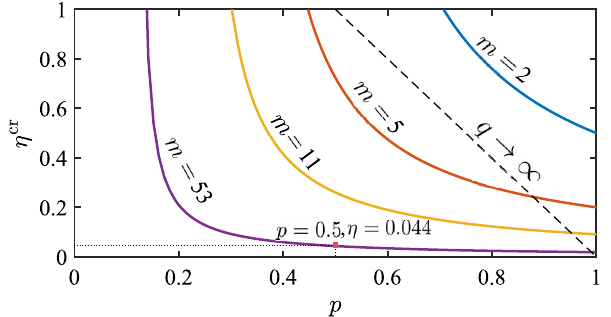
FIG. 2. Noise robustness and loss tolerance. Dependence of the critical heralding efficiency η cr for Alice with respect to the noise parameter p in the bipartite shared state ρ AB ð p Þ when using m ¼ d MUB measurement settings to demonstrate EPR steering in dimension d . By increasing the number of measurement settings m (or increasing the dimensions d ), the critical efficiency η cr decreases substantially, even at significant noise levels ( p < 1 ). For example, with m ¼ 53 MUB settings, one can tolerate a heralding efficiency as low as η ¼ 0 . 044 and a noise parameter p ¼ 0 . 5 (equal mixture of maximally entangled state and white noise). In contrast, demonstrating steering with qubit entanglement ( d ¼ 2 ) requires significantly higher heralding efficiencies η and a noise parameter p > 0 . 5 in the impractical cr limit of infinite measurement settings ( q → ∞ , dashed line) [18]. Thus, high-dimensional entanglement enables us to access regimes of noise and loss that are inaccessible by qubit entan- glement, even in the best-case